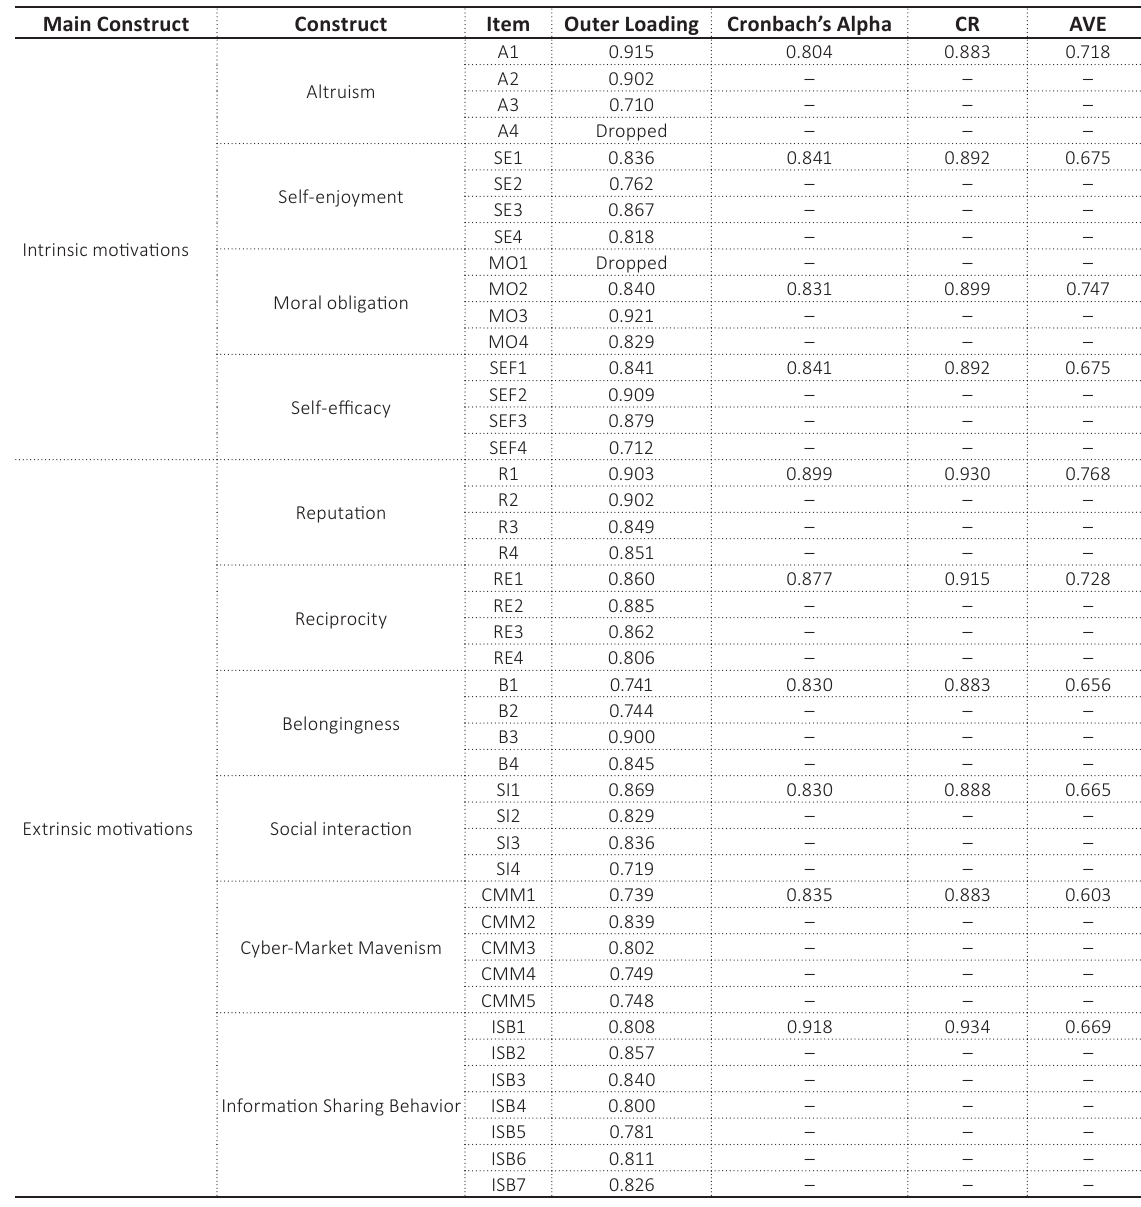
Table 3. Measurement items and their